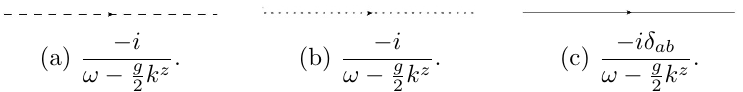
Figure 1. Feynman rules for the propagators: dashed long spaced lines ((cid:12)gure 1a) denote h (cid:30) 1 (cid:30) 1 (cid:3) i , dotted lines ((cid:12)gure 1b) denote h (cid:30) 2 (cid:30) 2 (cid:3) i , solid lines ((cid:12)gure 1c) denote h a (cid:3)